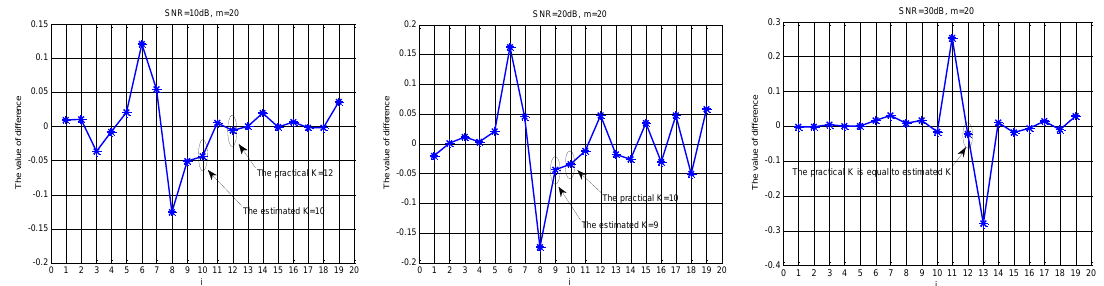
Figure 6. The estimation of the sparsity order under different SNR levels.